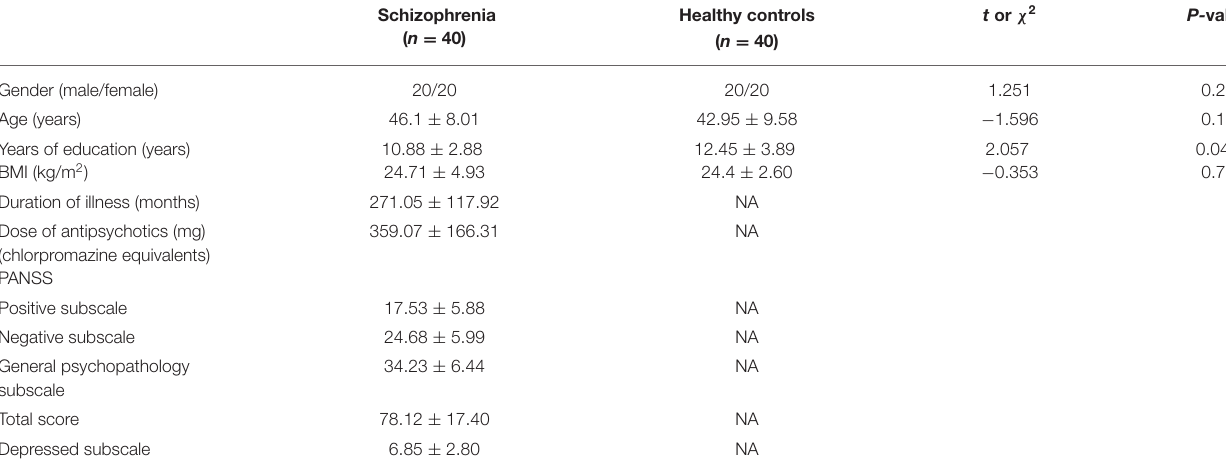
TABLE 1 | Demographics and clinical assessment of schizophrenia and healthy